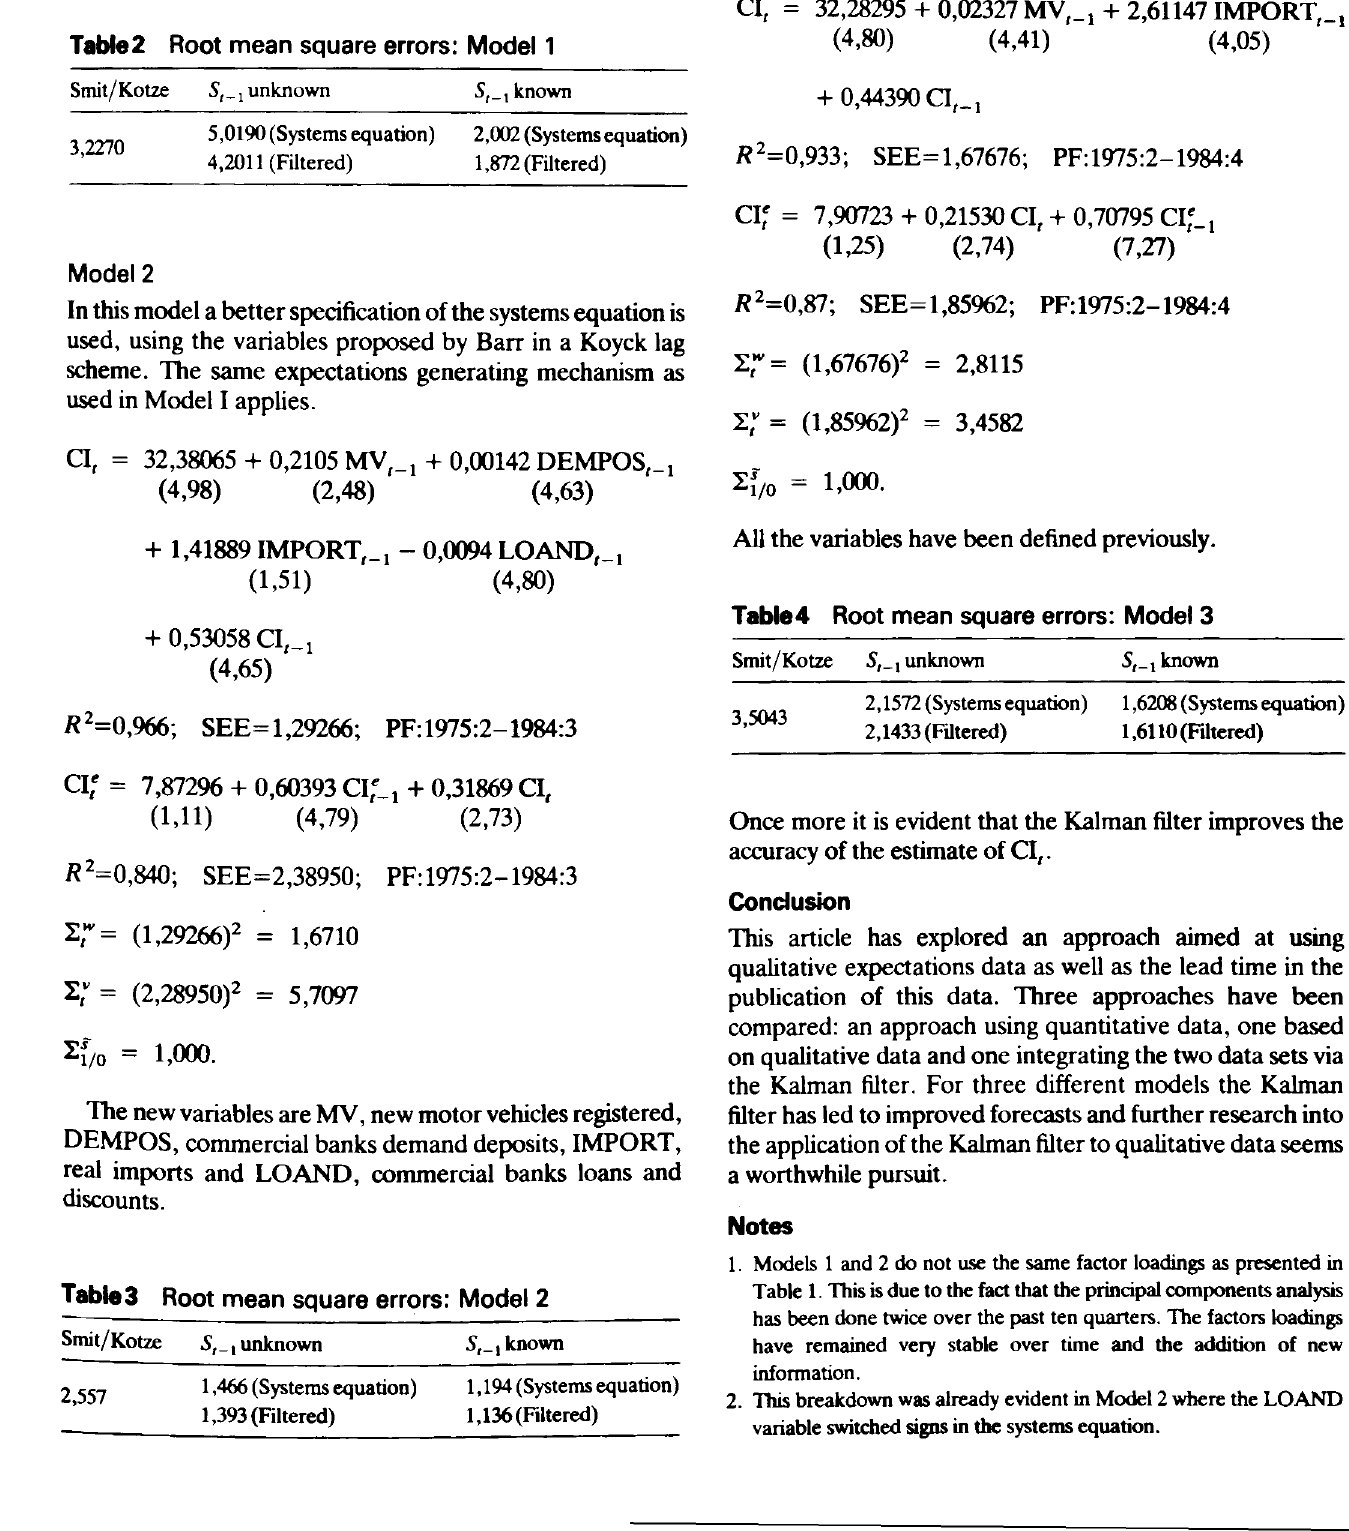
Table2 Root mean square errors: Model 1